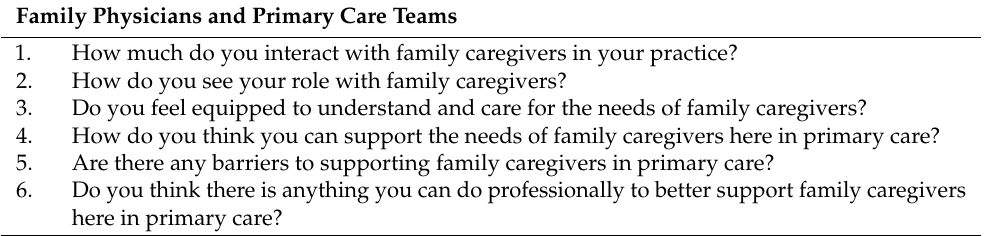
Table 1. Focus Group Semi-Structured Interview Guide.